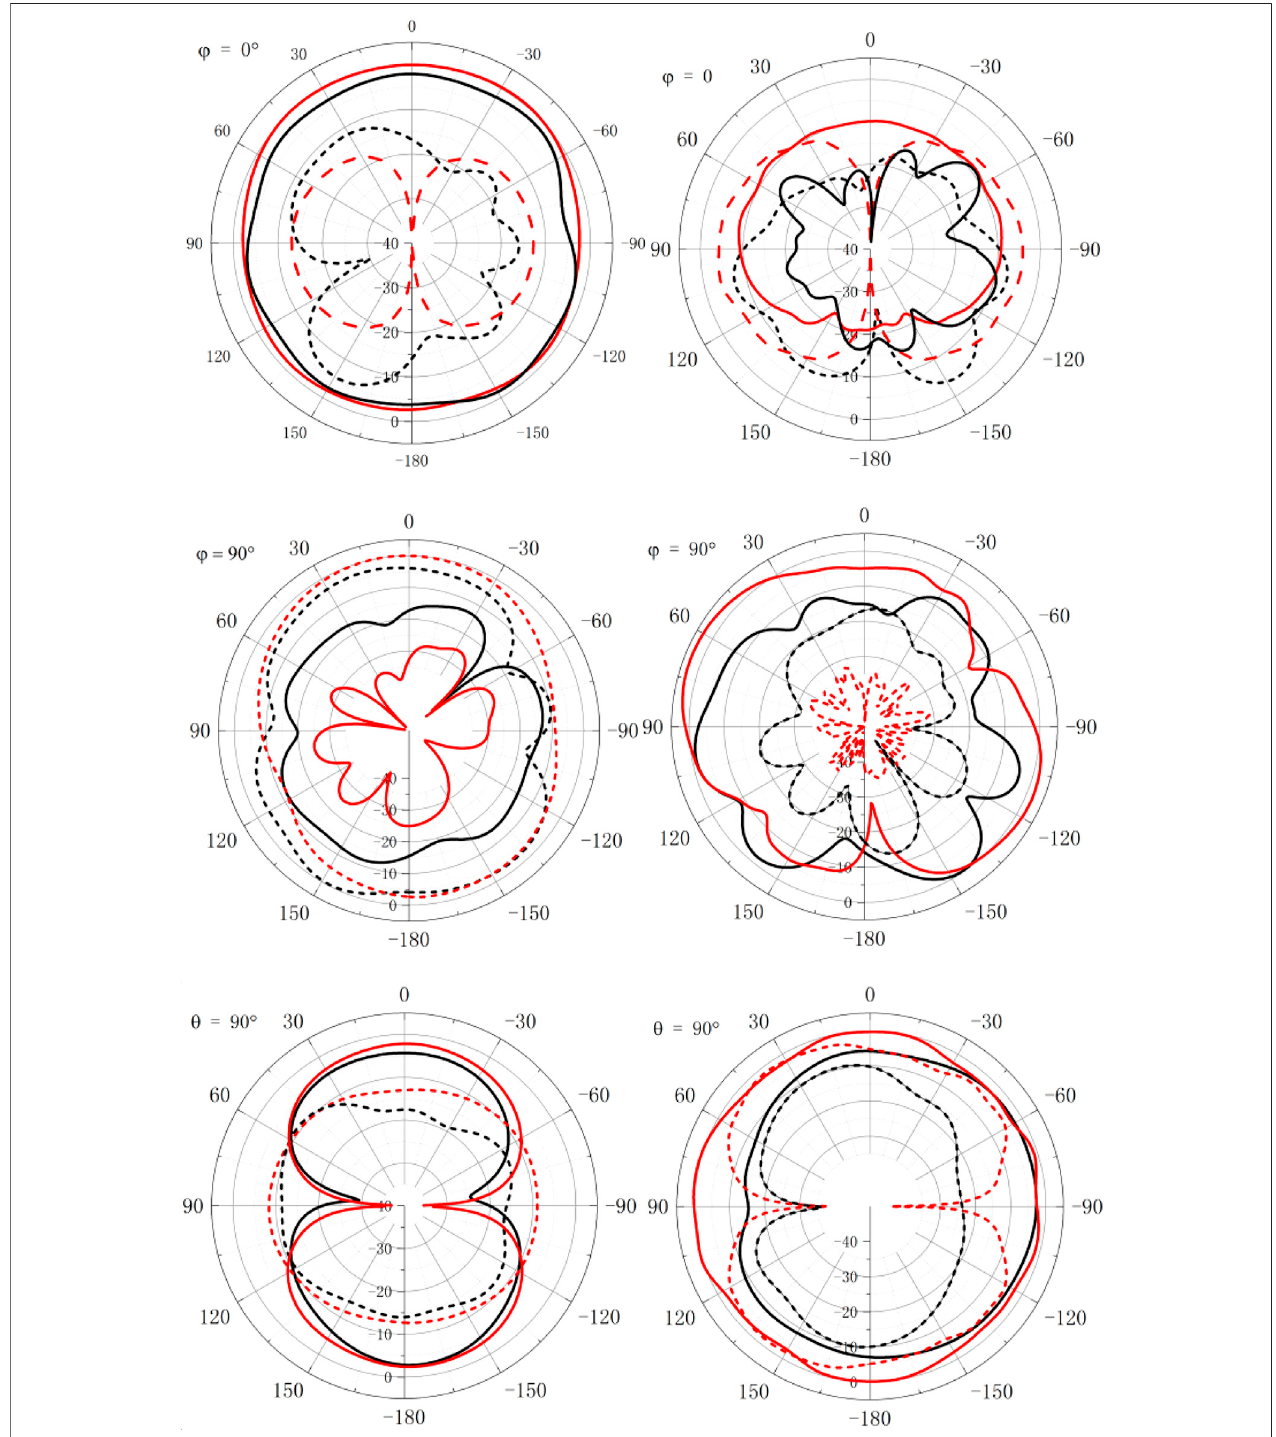
FIGURE 6 | Measured and simulated radiation patterns of the wearable antenna for the x-z, y-z, and x-y planes at 2.4 GHz (left) and 5.8 GHz (right). Solid lines indicate the E φ component and dashed lines for E θ component. Red lines indicate the simulated patterns and black lines for measured patterns.